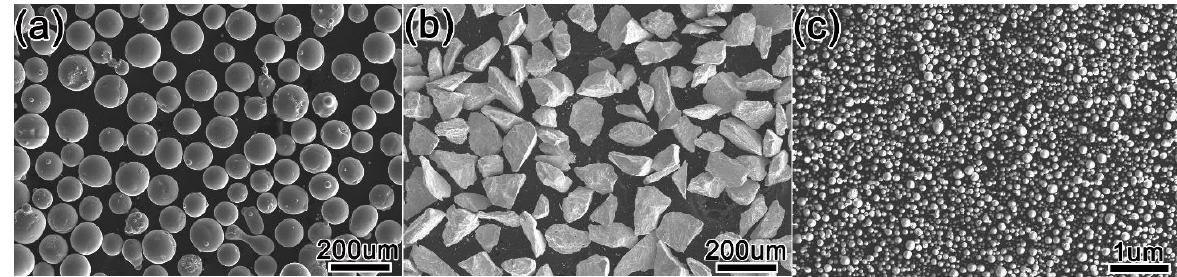
Figure 1. Morphology of the three powders ( a ) Ni60, ( b ) WC, and ( c ) Nano-Y 2 O 3.